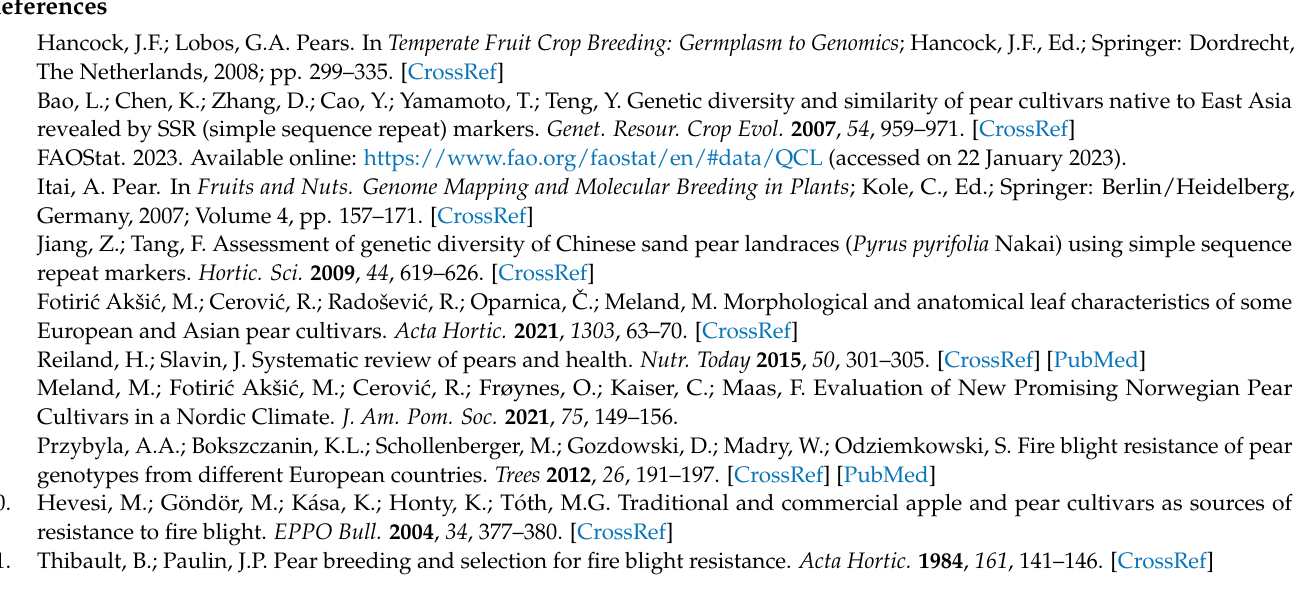
Figure A2. Fragmentation pathway of patuletin 3- O -(6 ″ -malonyl)-hexoside (compound 20).